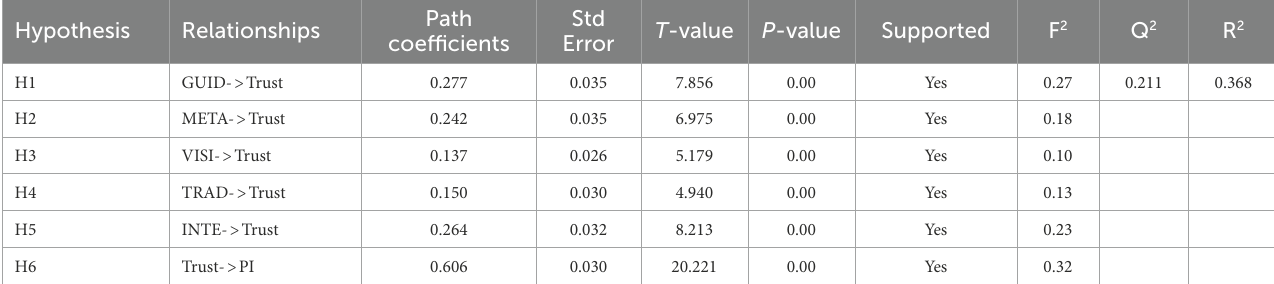
TABLE 4 Structural model